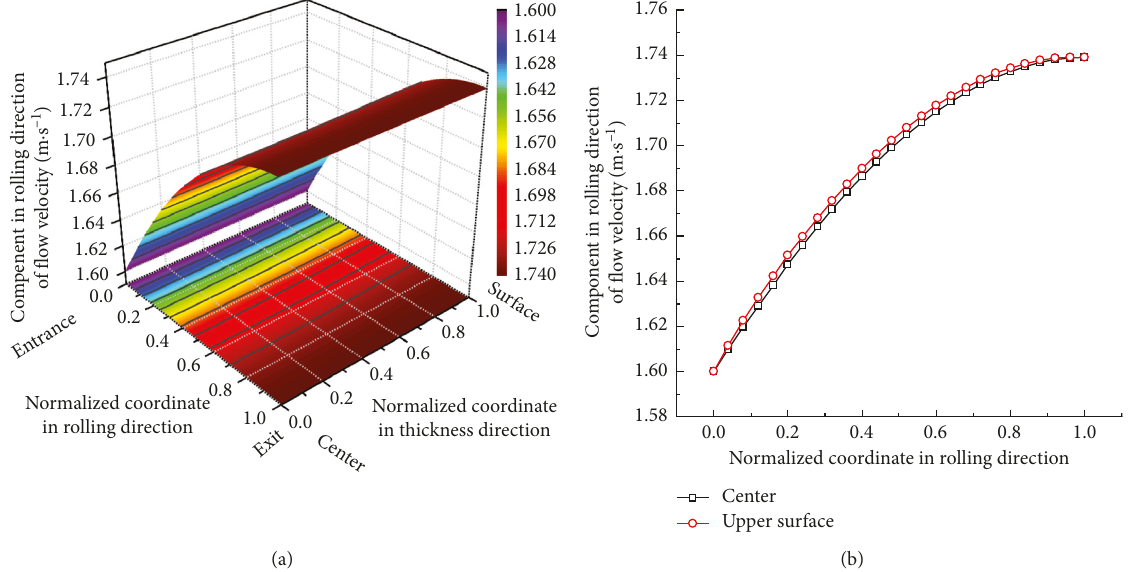
Figure 6: Distribution of flow velocity in the rolling direction with H � 0.5 m, h � 0.46m, R � 0.3 m, and v comparison of flow velocity between the surface and center of plate.